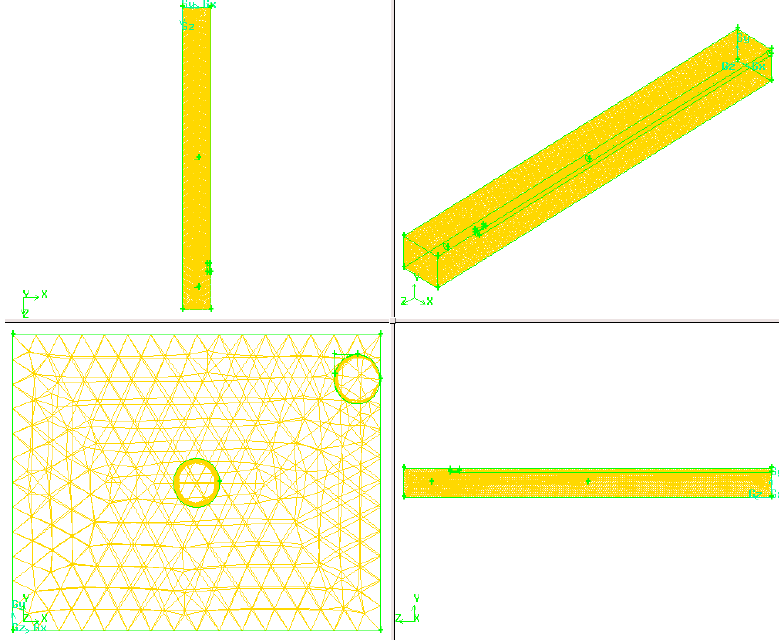
Figure 2. Meshes for the physical model.